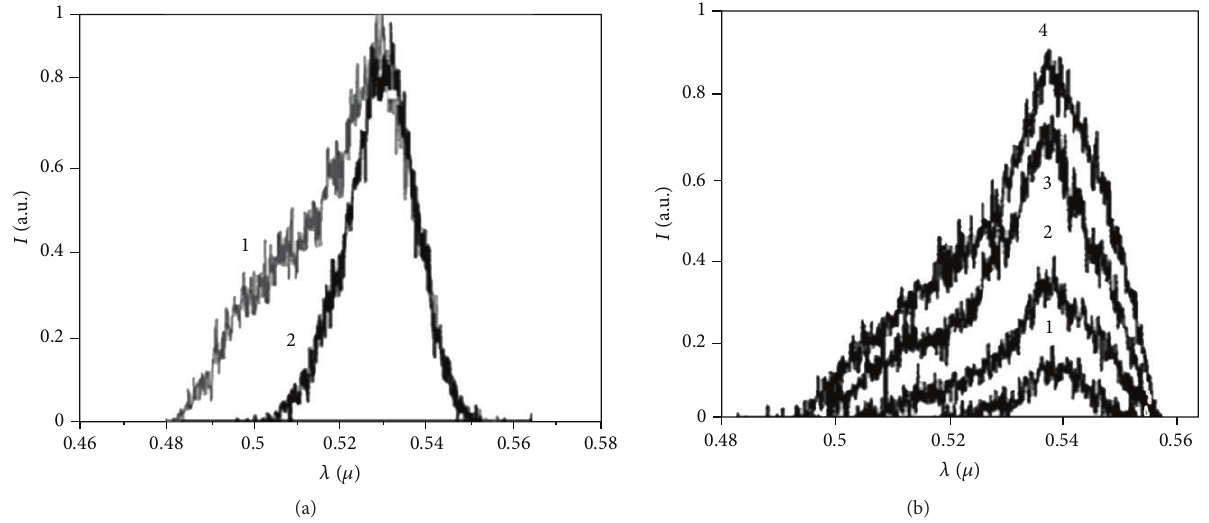
Figure 2: Spectra of converted broadband radiation for convergent input beams in LN: (a) type of phase matching: 1− oo - e ; 2− oe - e and (b) for different temperatures of thermal object: 1–1940K; 2–2097 K; 3–2337 K; 4–2456